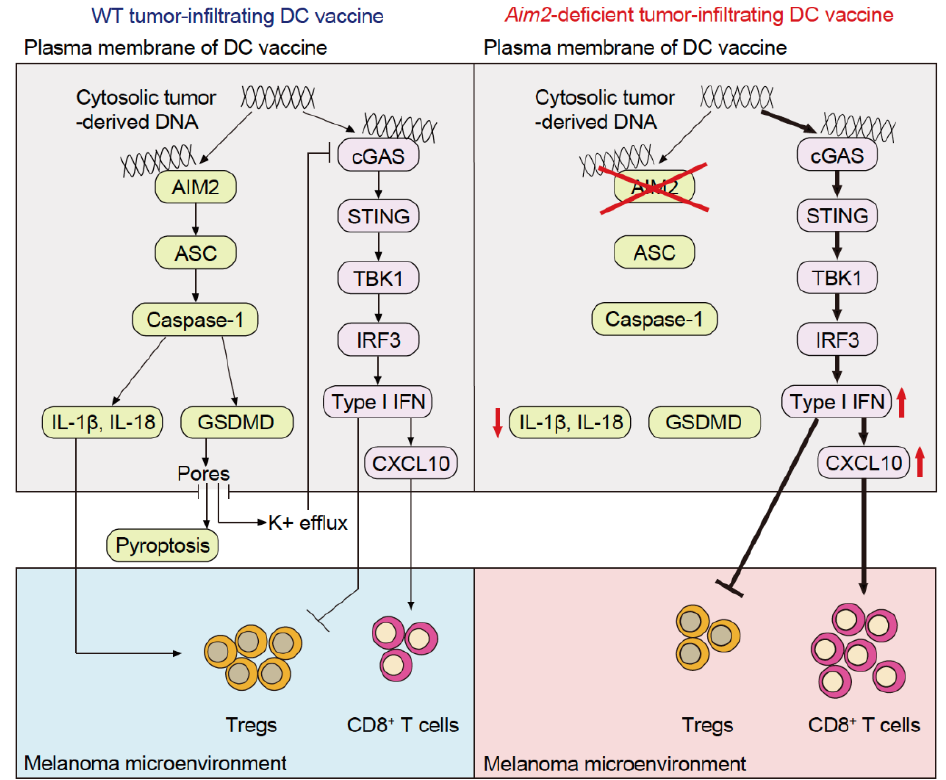
Figure 3. Tumor immunosuppressive mechanism of AIM2 in TIDCs. Upon recognizing the tumor- derived DNA taken up into the TIDC cytoplasm, AIM2 induces the production of IL-1 β and IL-18, which in turn promote the intratumoral infiltration of regulatory T-cells (Tregs). Additionally, AIM2 suppresses STING type I IFN signaling, a pathway that promotes intratumoral infiltration of CD8 + T-cells and suppresses that of Tregs.